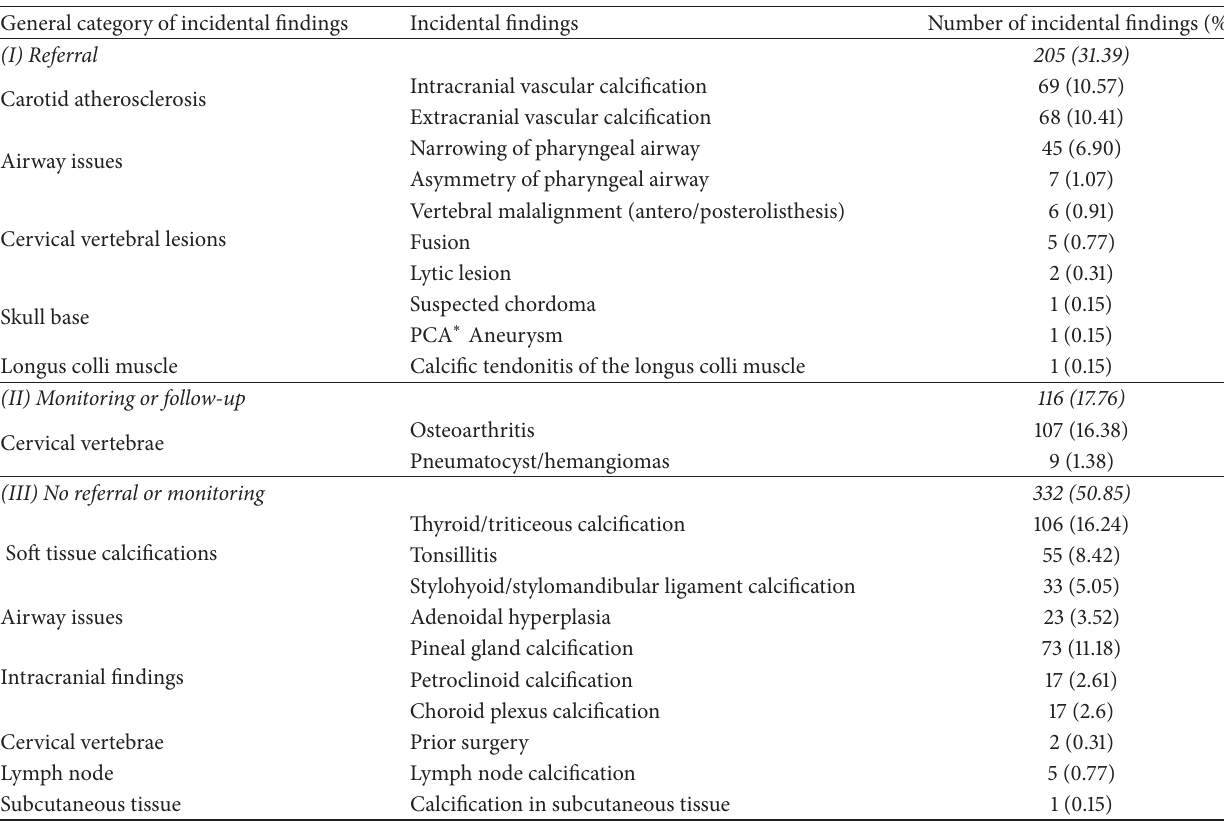
Table 3: Clinical significance of the incidental findings.